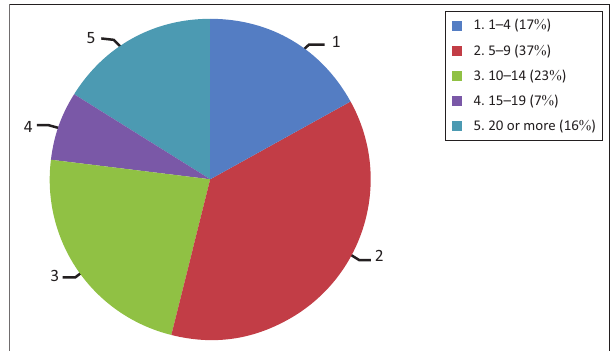
FIGURE 4: Number of Internet sites accessed that require passwords.